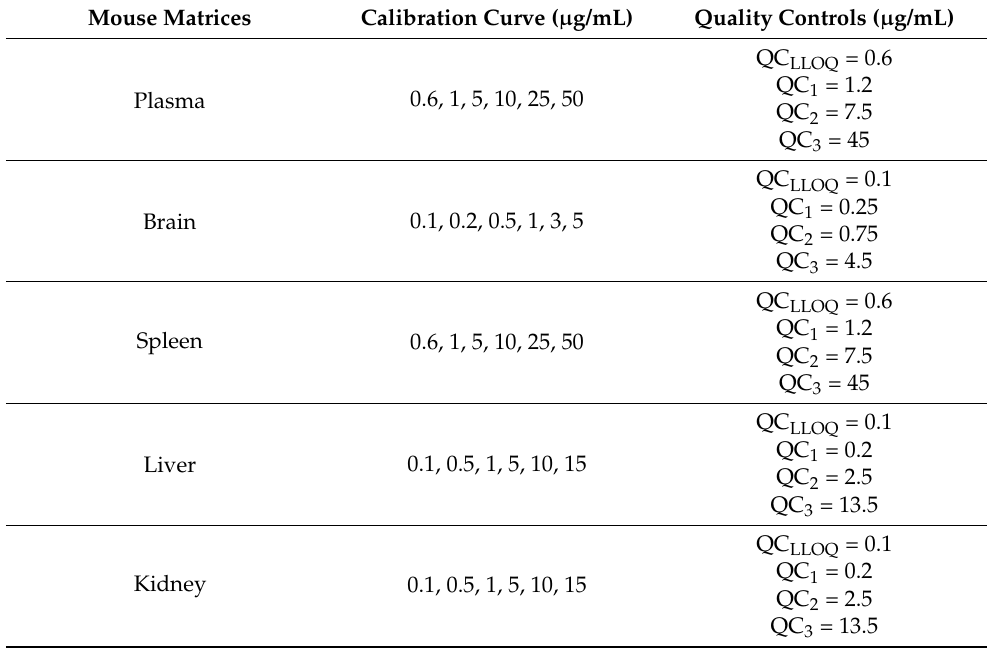
Table 1. Final concentrations of the calibration standards and quality